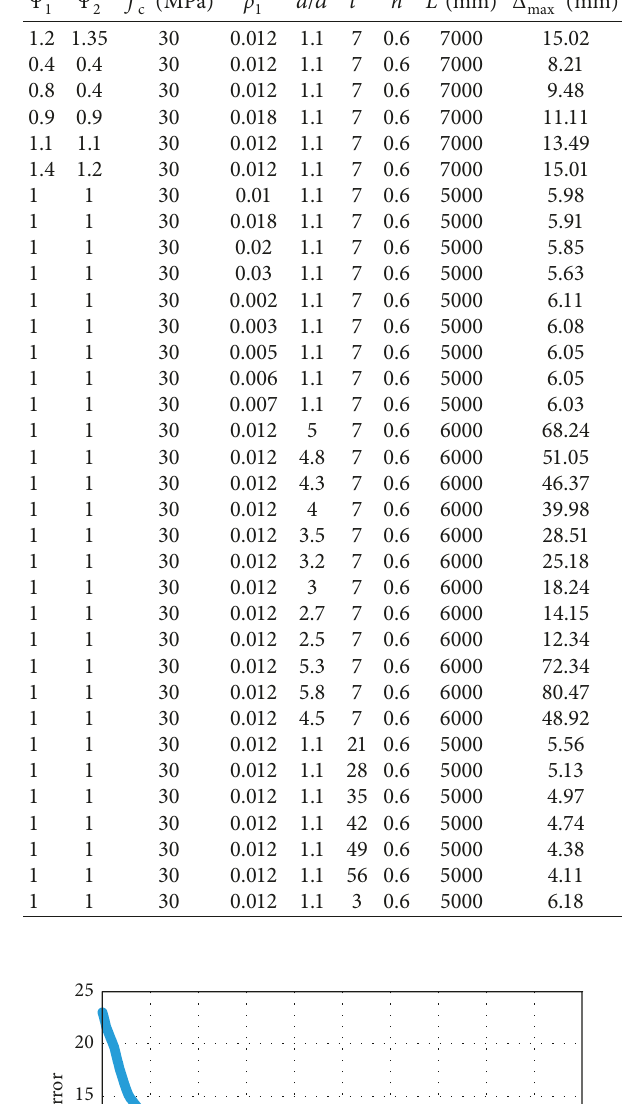
Table 5: Train data used in ANFIS for the load level of 40% of the beam strength (100 input-output datasets).